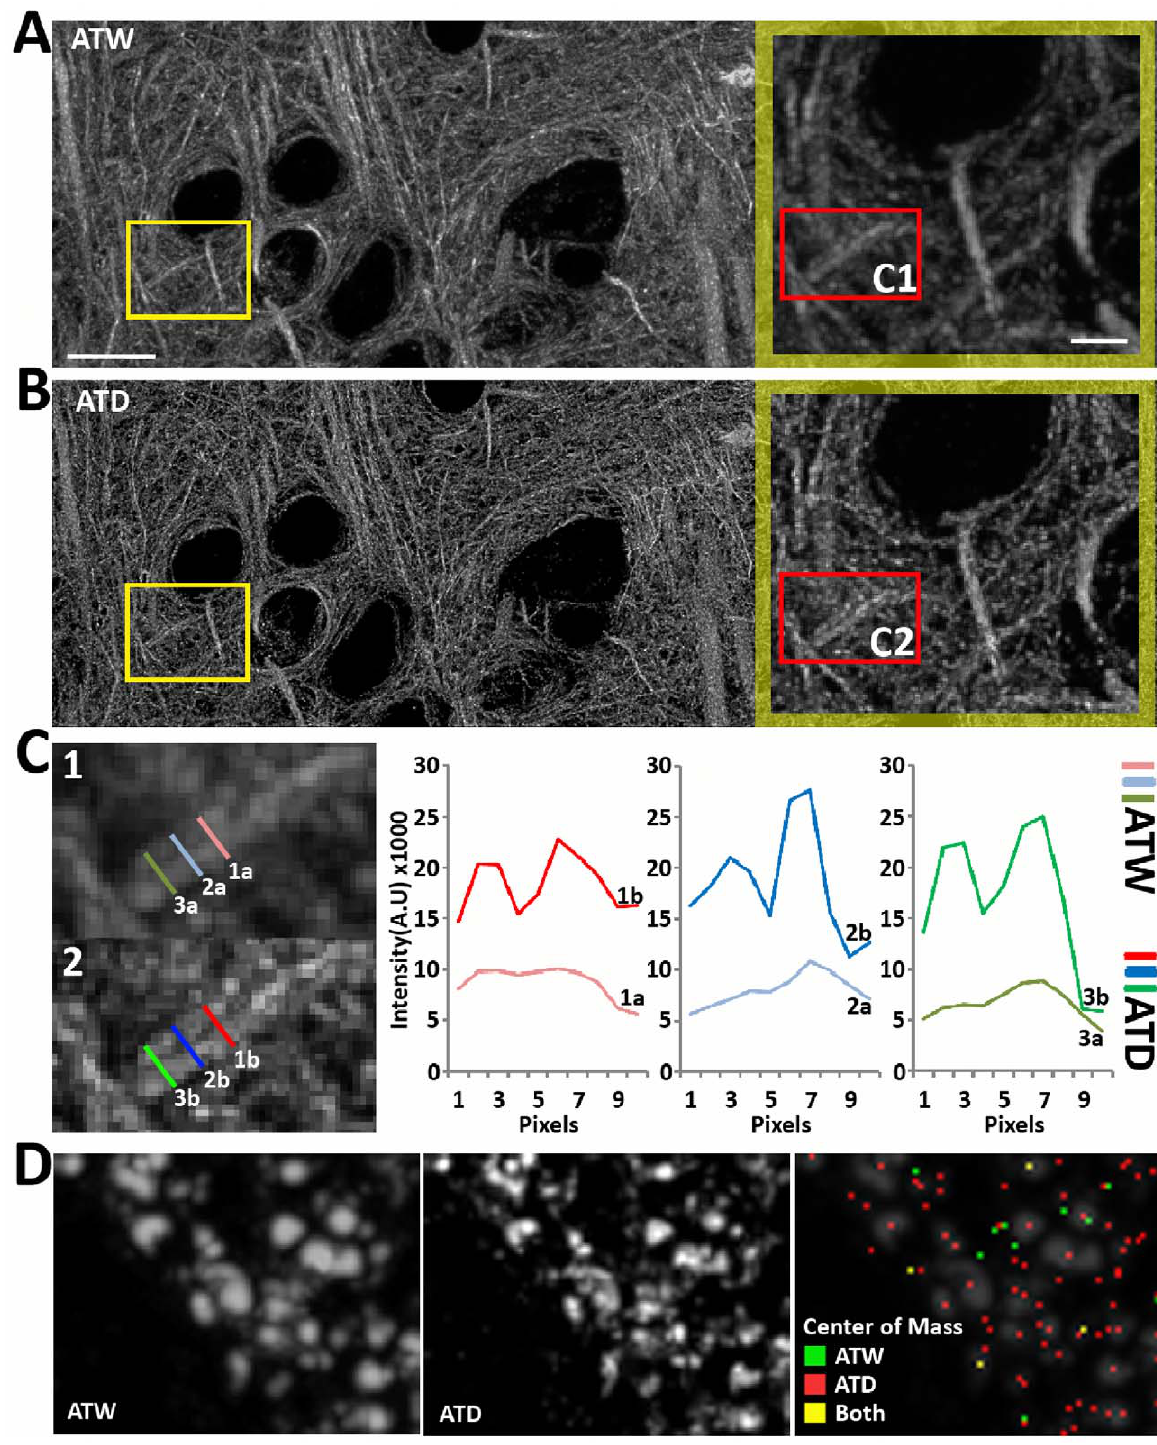
Figure 4. Deconvolution improves computational resolution of fine cellular structures. (A–C) Comparison of microtubules before and after deconvolution. Images are max projection of AT volumes composed of twenty 70 nm sections. (A–B) It is clear that there is more contrast and higher frequency information is more visible in the deconvolved image. Scale Bar 10 um. Blow-up: Scale Bar 2 um. (B–C) We quantify two parallel microtubules separated by one pixel distance at the cross sections marked in the blow-up images in (B). Scale Bar=1 um. Intensity cross sections (C) along the length of the microtubules show that the peaks of the microtubules are clearly resolved in the deconvolved case, as compared to the original image, where the peaks are barely separated. (D) Deconvolution of Synapsin puncta, a presynaptic protein, makes individual puncti more readily resolvable. Images are max projection of 15 AT sections. More importantly, computationally calculated 3D centers of mass are more accurate and better represent the number of puncta visible after deconvolution. Scale Bar=1